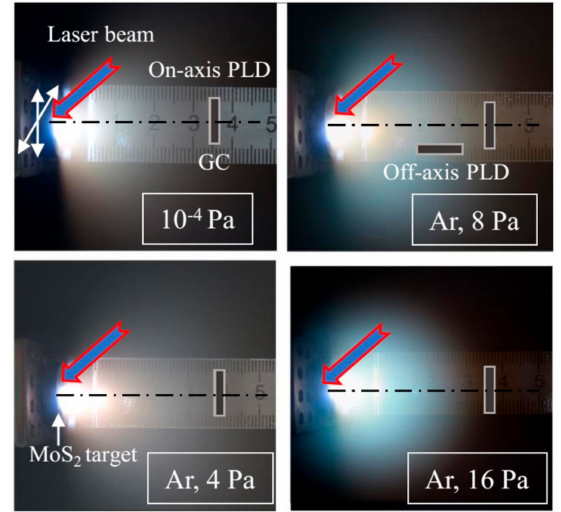
Figure 1. Time integrated optical images of the laser plume formed during the pulsed laser deposition of MoS x films from a MoS 2 target under vacuum, considering various pressures of the Ar bu ff er gas. The arrangement of glassy carbon (GC) substrates, with respect to the axis of laser plume expansion, is shown for the modes of on- and o ff -axis pulsed laser deposition